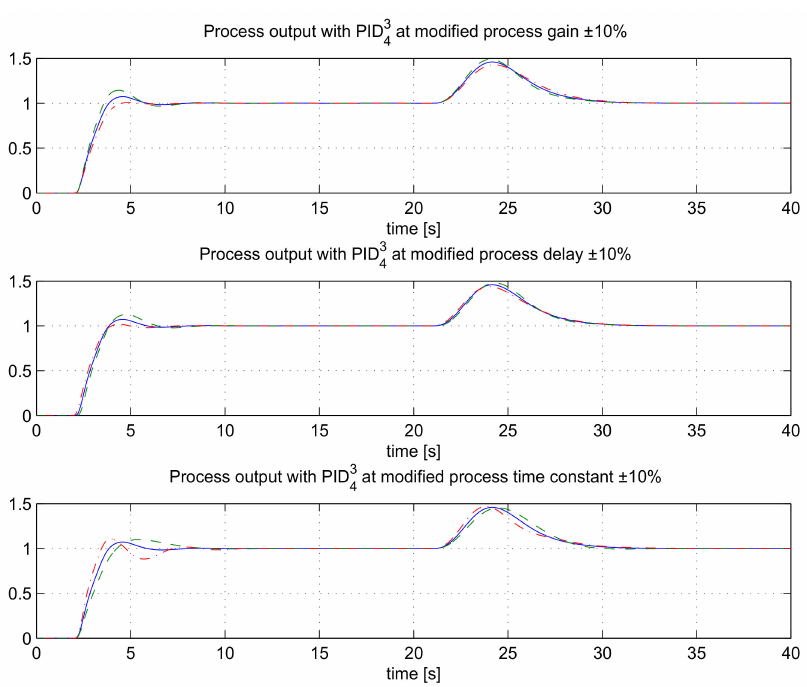
Figure 11. The closed-loop responses for the process G P 4 ( s ), using controller PID 3 for nominal (solid line), 10% increased (dashed line) and 10% decreased (dash-dotted line) process parameters.